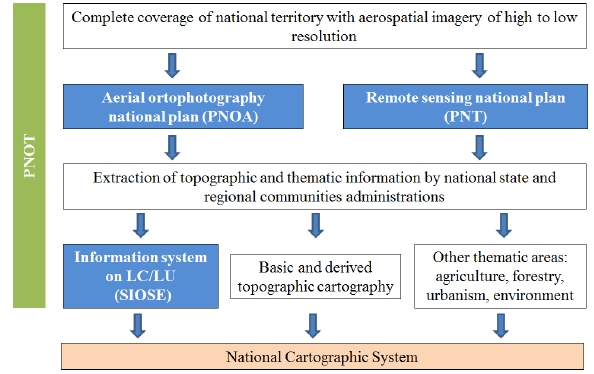
Figure 2: Spanish National Plan for Land Observation (PNOT)